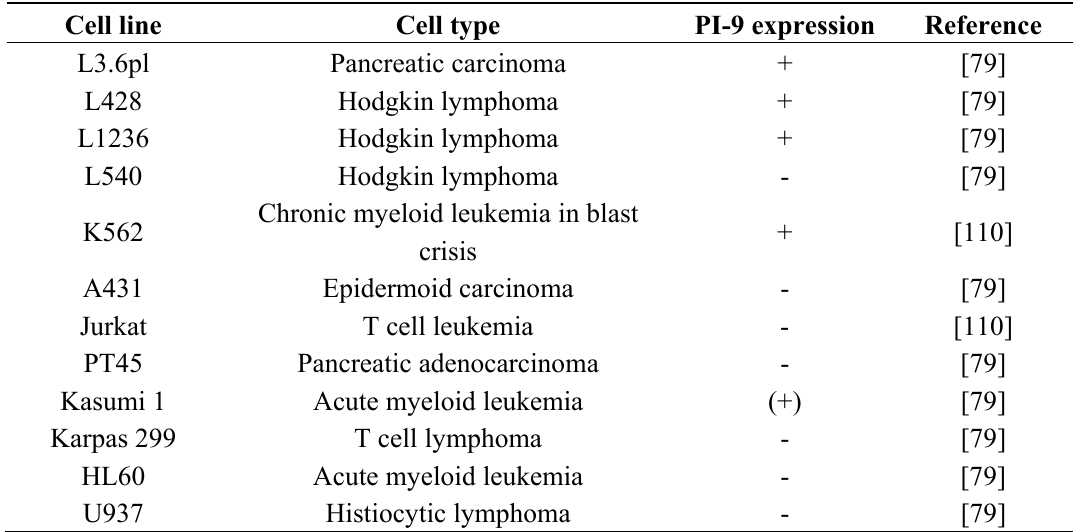
Table 2. Overview of PI-9 expression on protein level based on western blot analysis within different cell lines used in our